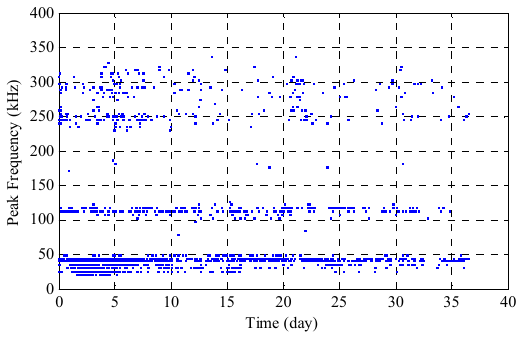
Figure 7. Peak frequency content from Transducer A.